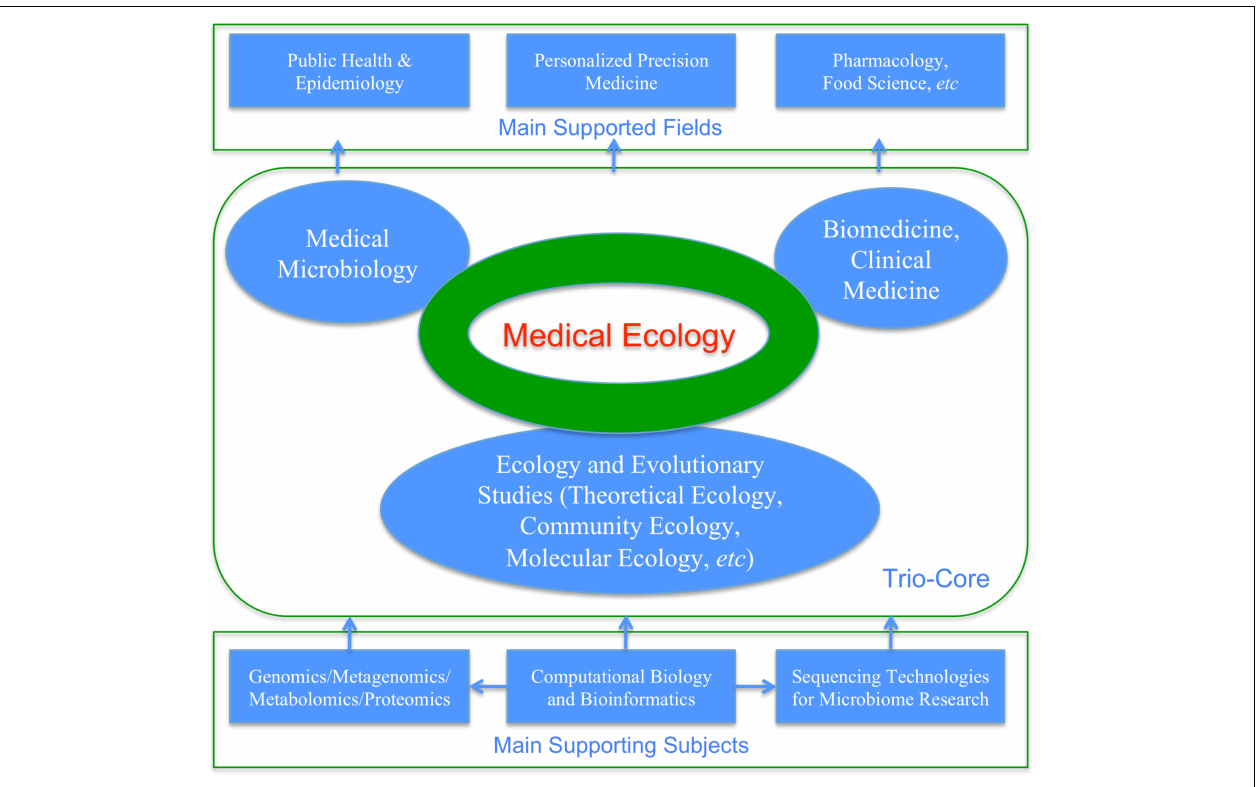
FIGURE 4 | Medical ecology: its trio-core, as well as its supporting and supported